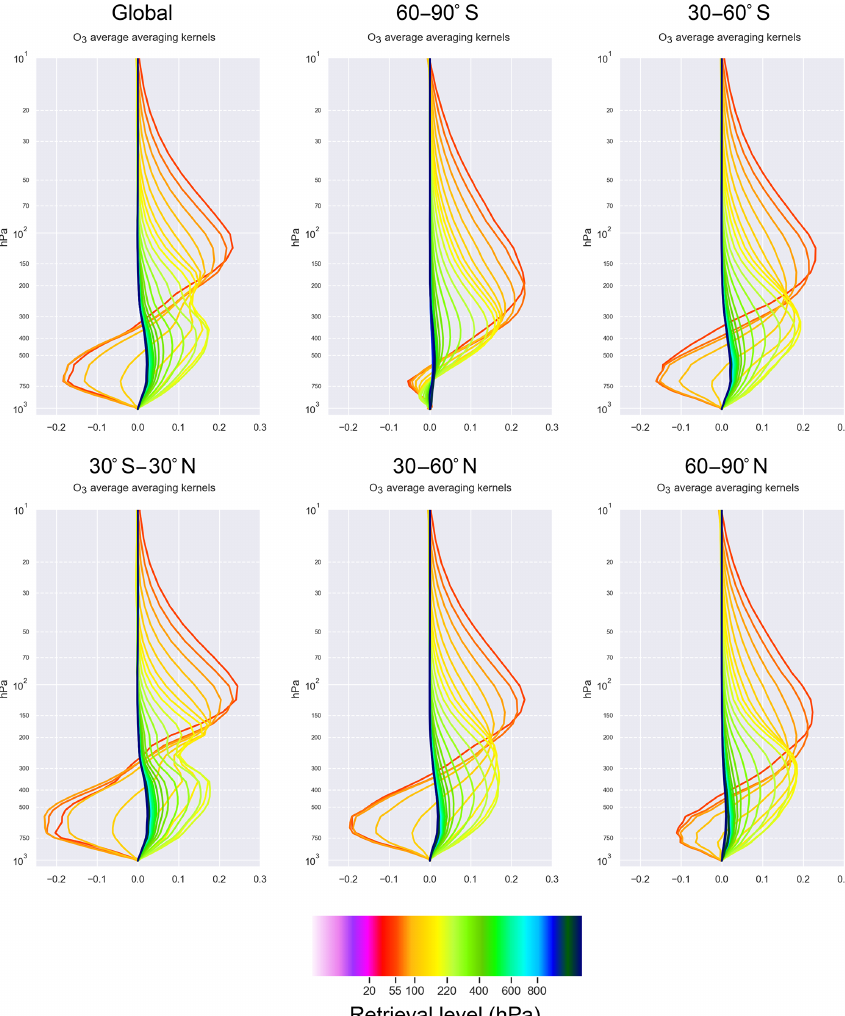
Figure 1. SOFRID O 3 averaging kernels for the month of July 2010 averaged globally (first plot) and for five separate latitude bands (90– 60 ◦ S, 60–30 ◦ S, 30 ◦ S–30 ◦ N, 30–60 ◦ N, 60–90 ◦ N). Each coloured line corresponds to a retrieval’s level, and the corresponding pressure is indicated in the colour bar. Only SOFRID levels with a pressure > 50hPa are displayed for better